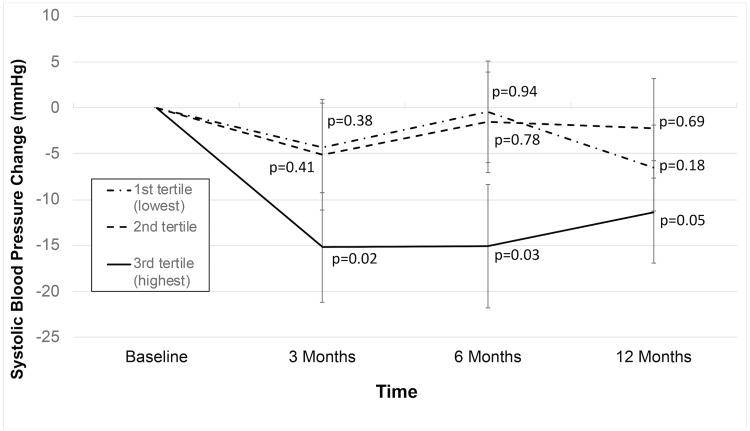
Mean systolic blood pressure (SPB) over one-year follow-up, stratified by tertile of formal home mindfulness practice amount during the eight week MB-BP course.Analyses were performed using hierarchical linear models. P-values represent comparison of respective follow-up time to baseline. Error bars are standard errors of the mean. Sample sizes for comparisons at 3, 6 and 12 months vs. baseline are 14, 13 and 11 respectively, for highest tertile of home practice, 15,14, and 14, respectively, for participants with medium tertile of home practice, and 15, 14, and 14, respectively, for participants with lowest tertile of home practice.